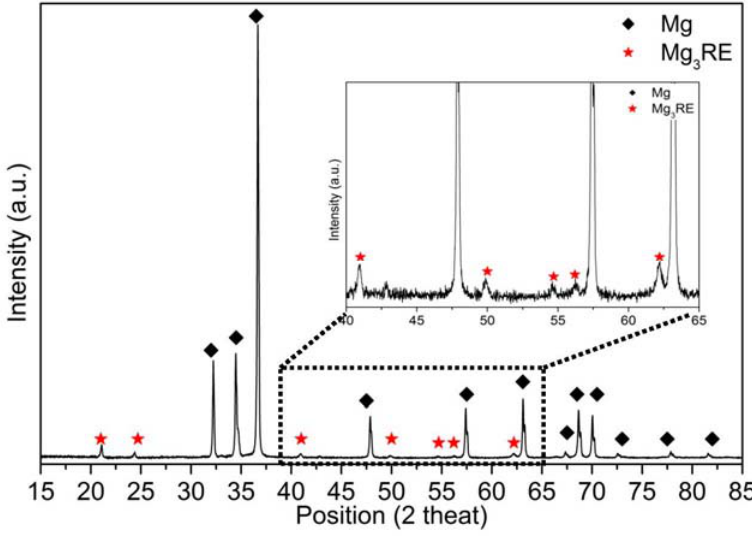
Figure 3. XRD spectra of as-cast El21.